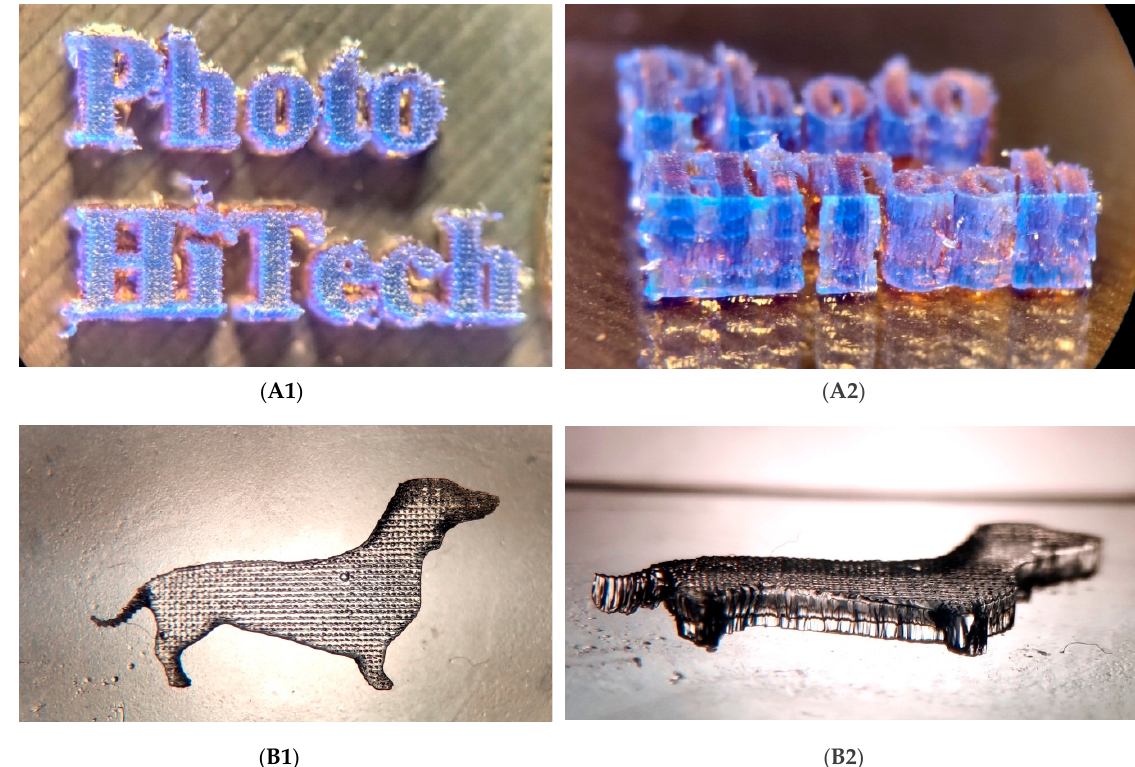
Figure 19. Micrography of ( A ) object “Photo HiTech” print obtained from purely cationic photosensitive formulations based on vinyl monomer (TEGDVE) with S8 / HIP (0.5% / 1.0% w / w ) photoinitiating system; ( A1 ) view from the top under a UV-LED source of light with a maximum emission at 365 nm; ( A2 ) side view at 45 o under a UV-LED source of light with a maximum emission at 365 nm. ( B ) Object “dog” print obtained from purely cationic photosensitive formulations based on cycloaliphatic epoxide monomer (CADE) with S8 / HIP (0.5% / 1.0% w / w ) photoinitiating system photoinitiating system; ( B1 ) view from the top in daylight; ( B2 ) side view at 45 ◦ in daylight.